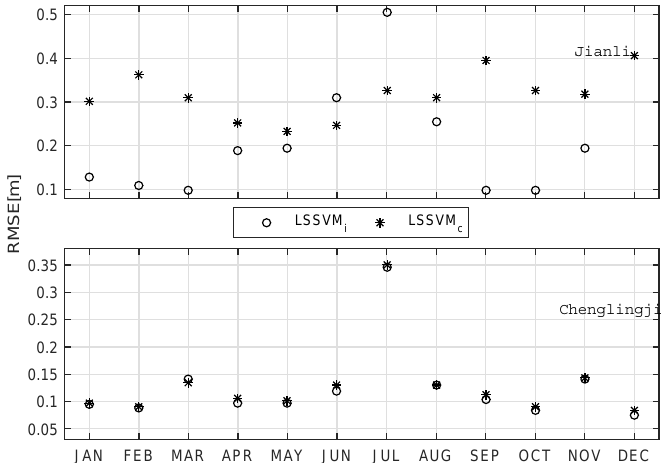
Figure 7. Temporal variation of RMSE through different months of year Figure 7 . Temporal variation of RMSE through different months of year 2016.